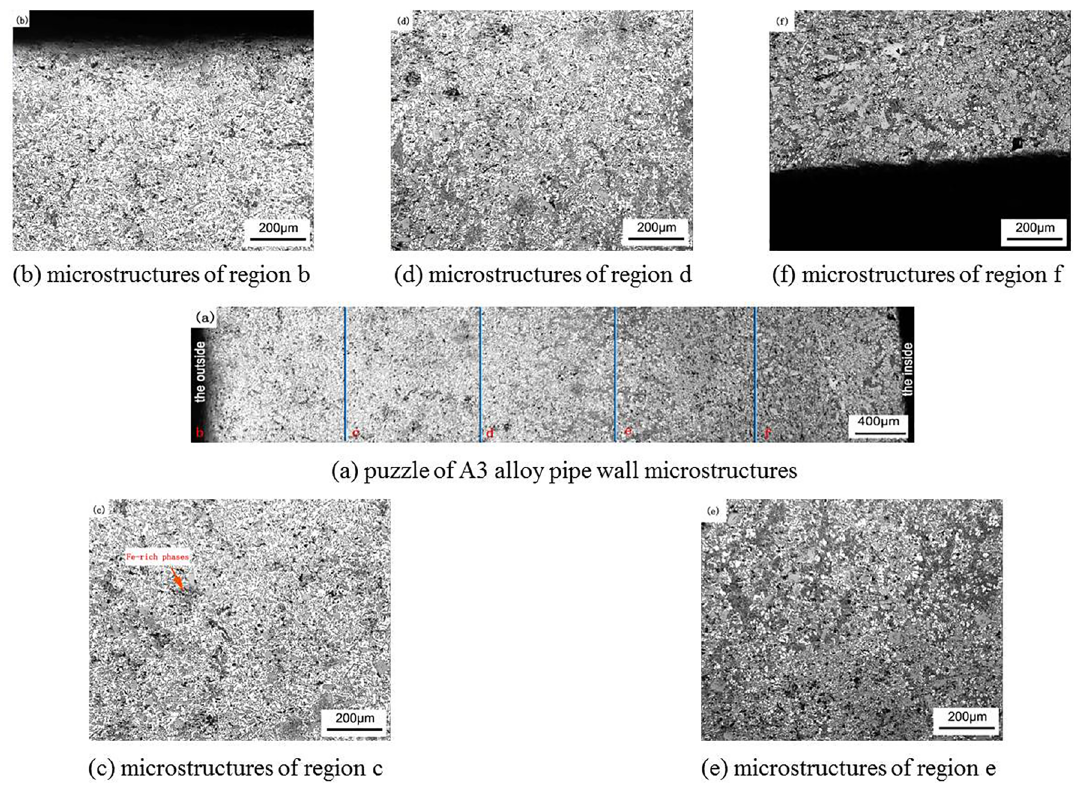
Figure 6. Rheo-squeeze casting A3 alloy pipe wall with gradient structure (a) puzzle of A3 alloy pipe wall microstructures; (b - f) microstructures of regions b - f.